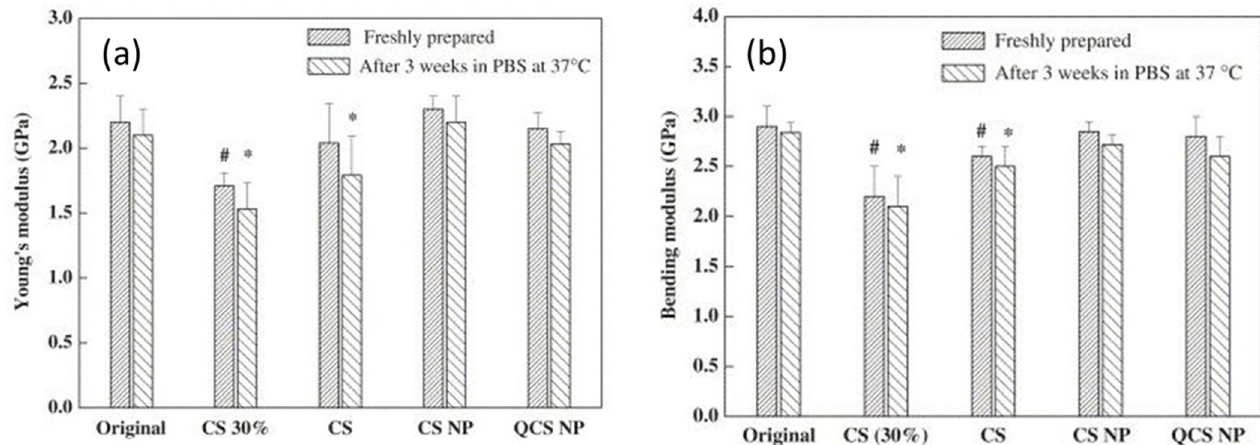
Figure 12. ( a ) Young’s modulus of original and C.S. (30%), C.S., CS NP- and QCS NP-loaded Smartset plain and gentamicin-loaded. ( b ) Bending modulus of original and C.S. (30%), C.S., CS NP- and QCS NP-loaded Smartset plain and gentamicin loaded. Except for C.S. (30%), the other substrates were mixed at a weight ratio of C.S. or QCS to PMMA bone cement powder of 15%. (#), (*) denote significant differences ( p < 0.05) compared with original bone cement, which is freshly prepared or after three weeks in PBS [56] . Reprinted with permission from ref. [56] . © 2021 Elsevier.